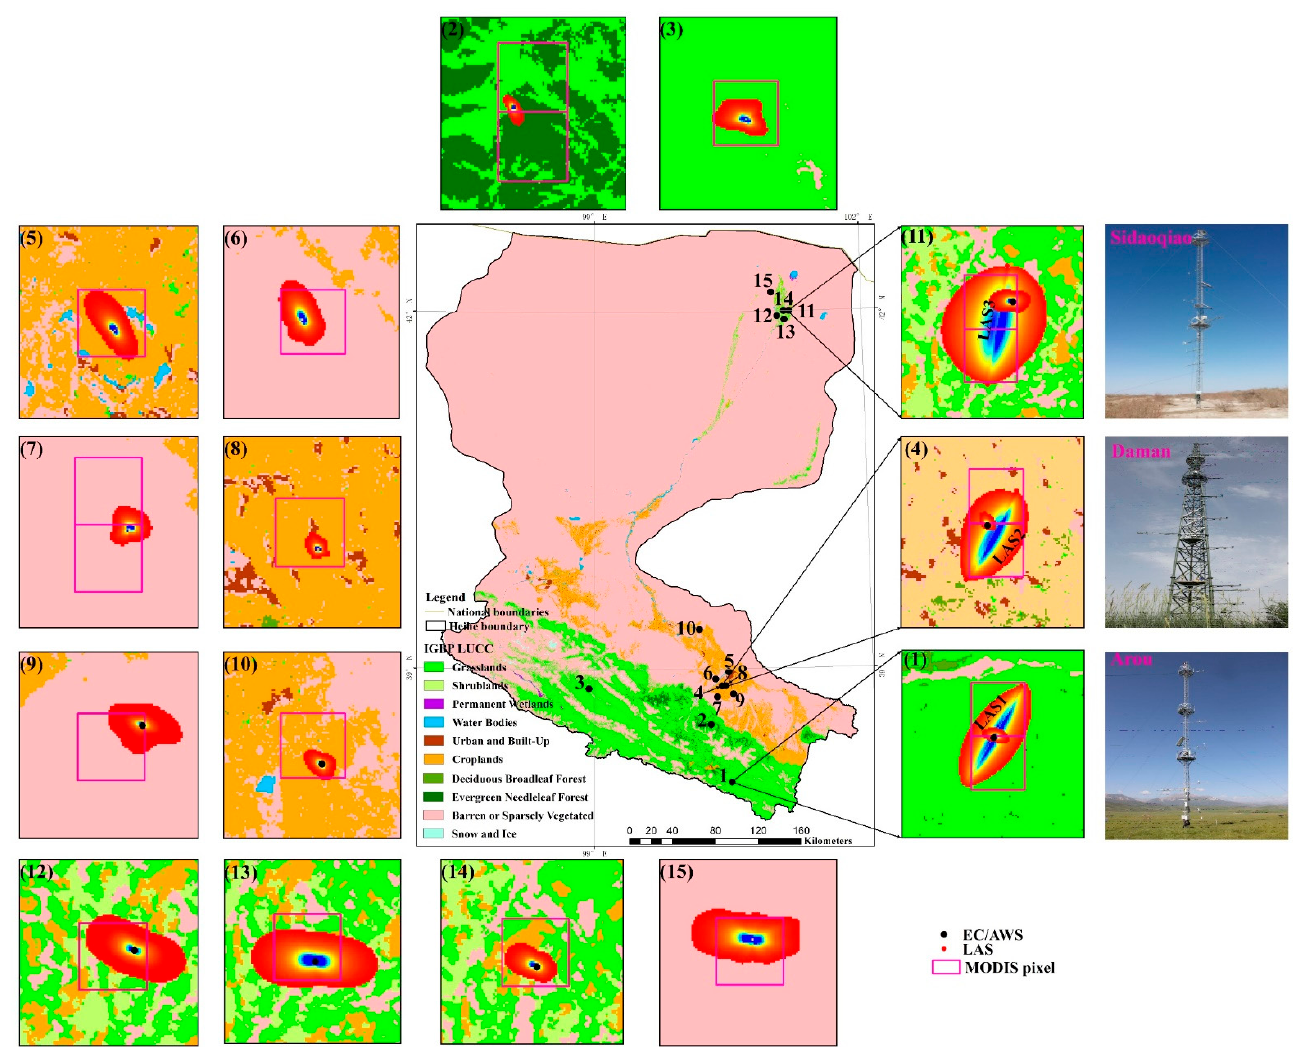
Figure 1. The spatial location of the HRB and the locations of the Arou superstation ( 1 ), Guantan station ( 2 ), and Dashalong ( 3 ) station in the upstream; the Daman superstation ( 4 ), Wetland ( 5 ), Bajitan Gobi ( 6 ), Huazhaizi Desert Steppe ( 7 ), Yingke ( 8 ), Shenshawo ( 9 ), and Linze ( 10 ) stations in the midstream; the Sidaoqiao superstation ( 11 ), the Populus euphratica ( 12 ), Mixed Forest ( 13 ), Barren Land ( 14 ), and Desert ( 15 ) stations in the downstream; and the filled ovals represent the flux source areas of the EC (at all stations) and LAS (at superstations) (corresponding to approximately 90% of the source area contribution), and the squares represent the corresponding 1 × 1 or 2 × 1 MODIS pixels. Table 1. Specifications of the stations in the HRB used in this study.